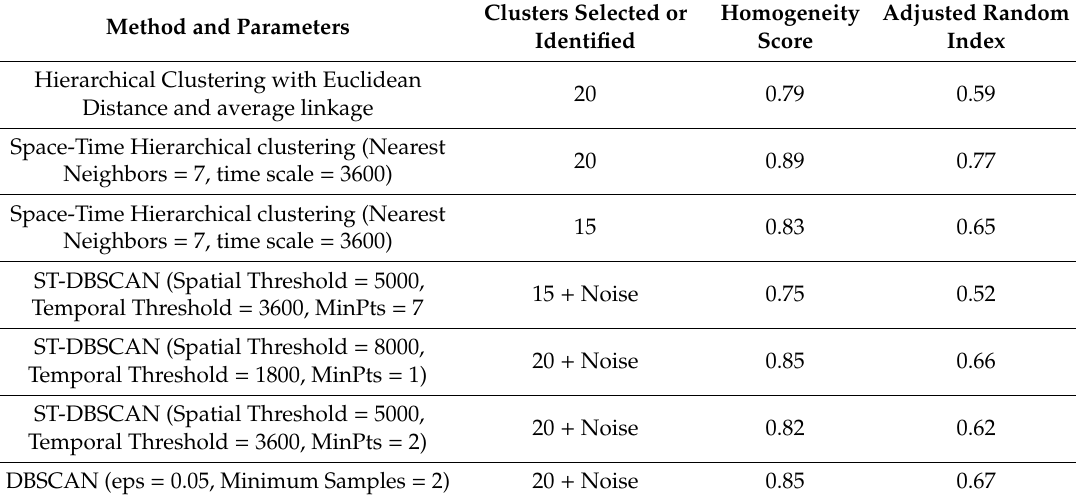
Table 2. Comparison of the di ff erent clustering algorithm and the performance compared to the true